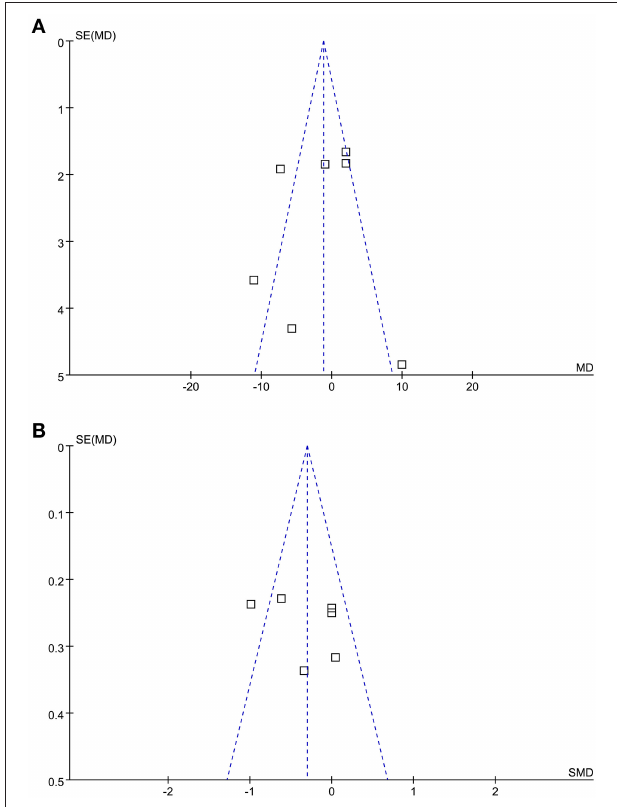
FIGURE 4 | Funnel plots for the meta-analysis of the quality of chest compression in medical personnel with and without PPE. (A) Funnel plots for the outcome of the rate of chest compression and (B) funnel plots for the outcome of the depth of chest